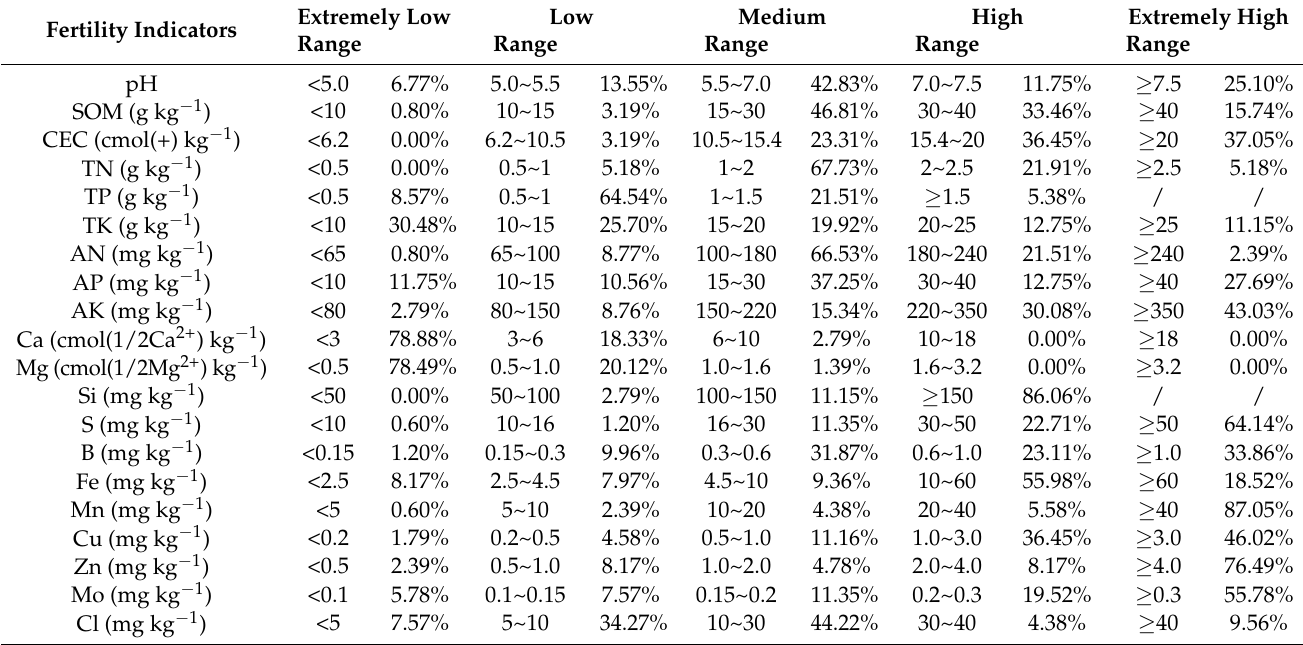
Table 3. Summary statistics of soil fertility